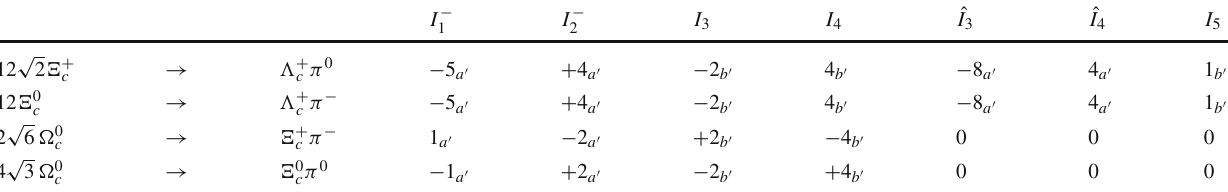
Table 9 Values of the seven tensor invariants for the (cid:2) C = 0 SCS decays of the single charm baryons (cid:6) + c , (cid:6) 0 c , and (cid:10) 0 c into antitriplet charm baryons induced by the flavor transitions ( a (cid:2) ) s → u ; u → d